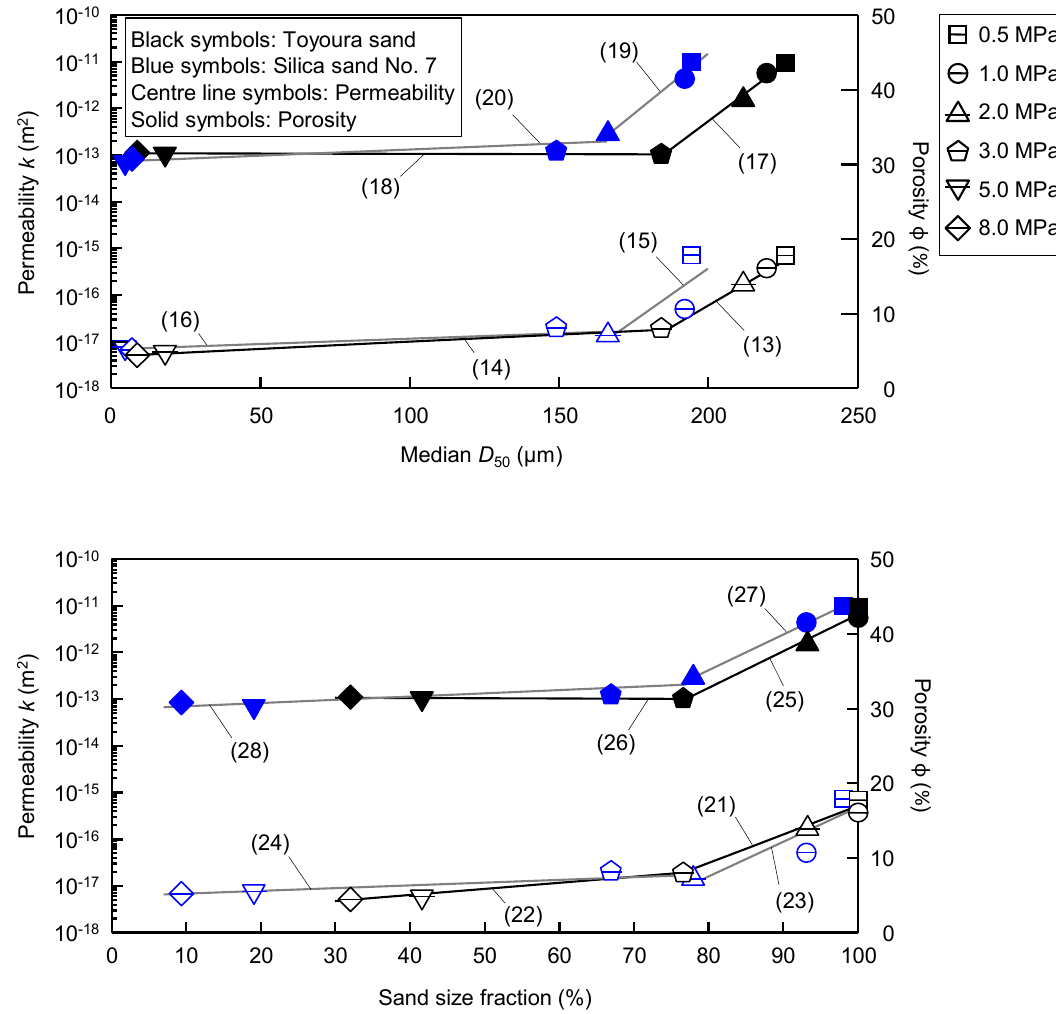
Figure 10. Permeability (centre line symbols) and porosity (solid symbols) plotted against median grain size and sand size fraction of shear zone samples of Toyoura sand (black symbols) and silica sand No. 7 (blue symbols). Numbers in parentheses indicate the correlations listed in Table